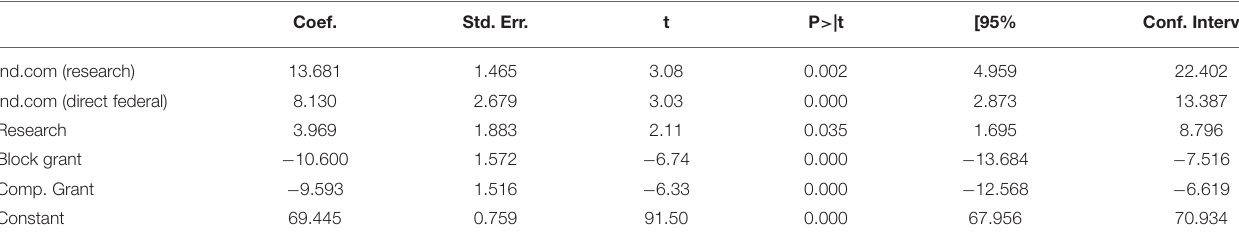
TABLE 7 | PART scores (OLS) by decision maker x commission, w/ interactions, model 4. Coef. Std. Err. Conf.